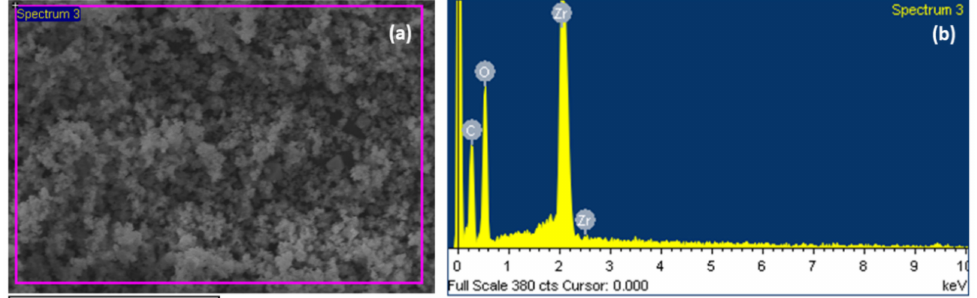
Figure 4. ( a ) SEM and ( b ) EDX analysis of MOF-801.